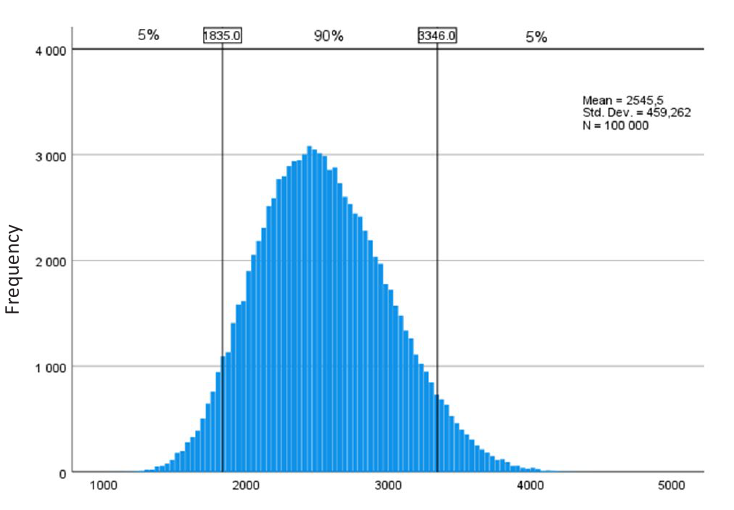
Margin for fixed costs, €/dairy cow/year Fig. 1. Distribution of margin for fixed costs in herds with 60 dairy cows, parlor milking, and selective dry cow therapy (probability of post-calving intramammary infection 0.24).